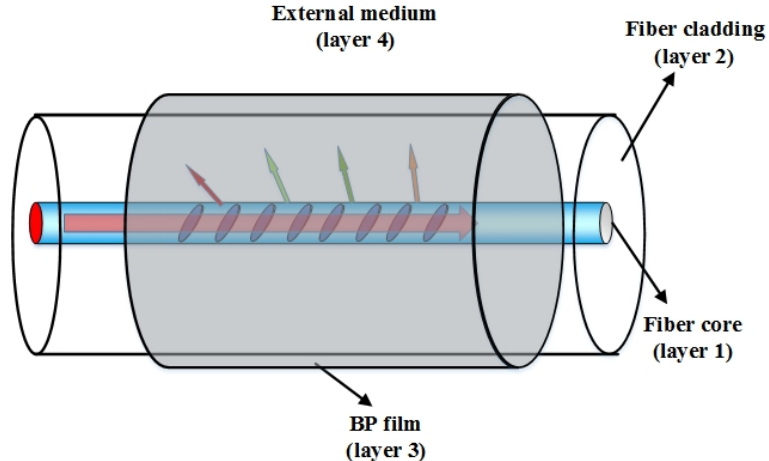
Figure 1. Schematic illustration black phosphorus (BP) coated weakly tilted fiber Bragg grating (WTFBG).